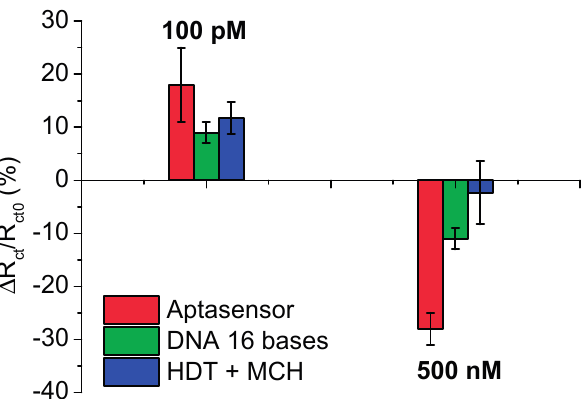
Figure 5. Interactions of thrombin in concentrations of 100 pM or 0.5 µM with screen-printed electrodes surfaces modified with thrombin aptamers/hexanedithiol (HDT) and backfilled with mercaptohexanol (MCH, red bars), DNA of 16 bases sequence co-immobilised with MCH (green bars) and HDT backfilled with MCH (blue